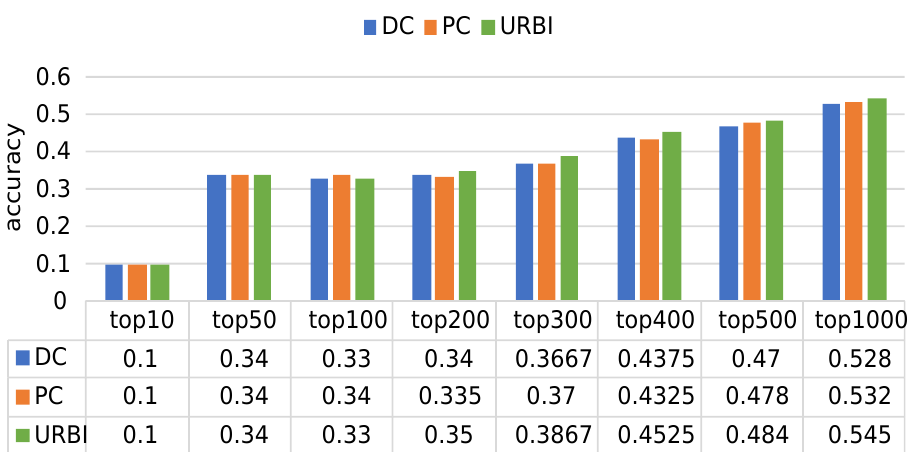
Figure 14. This figure depicts the experimental results of dataset No.14, which contains 9972 book nodes.